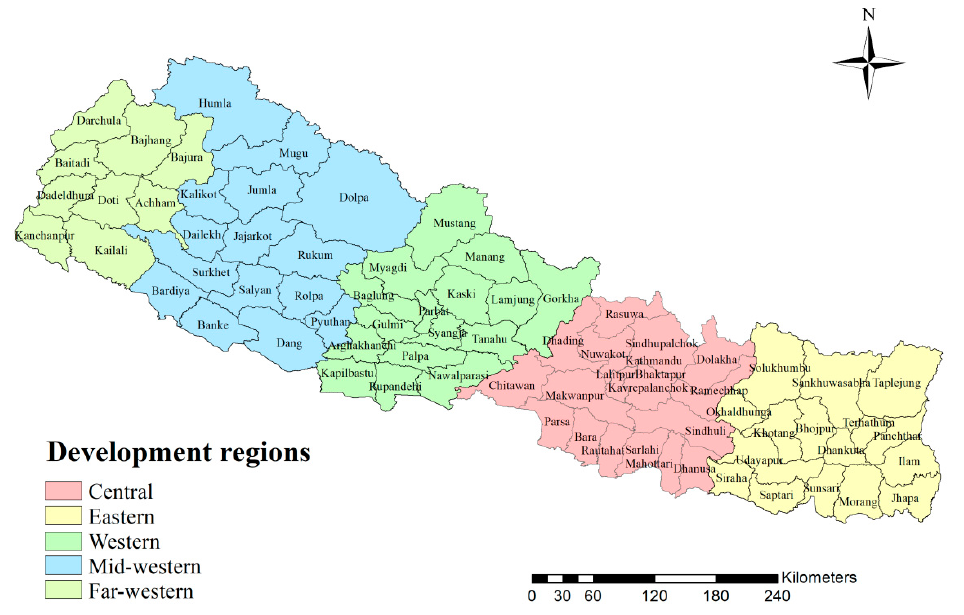
Figure 1. Development regions and districts in Nepal.